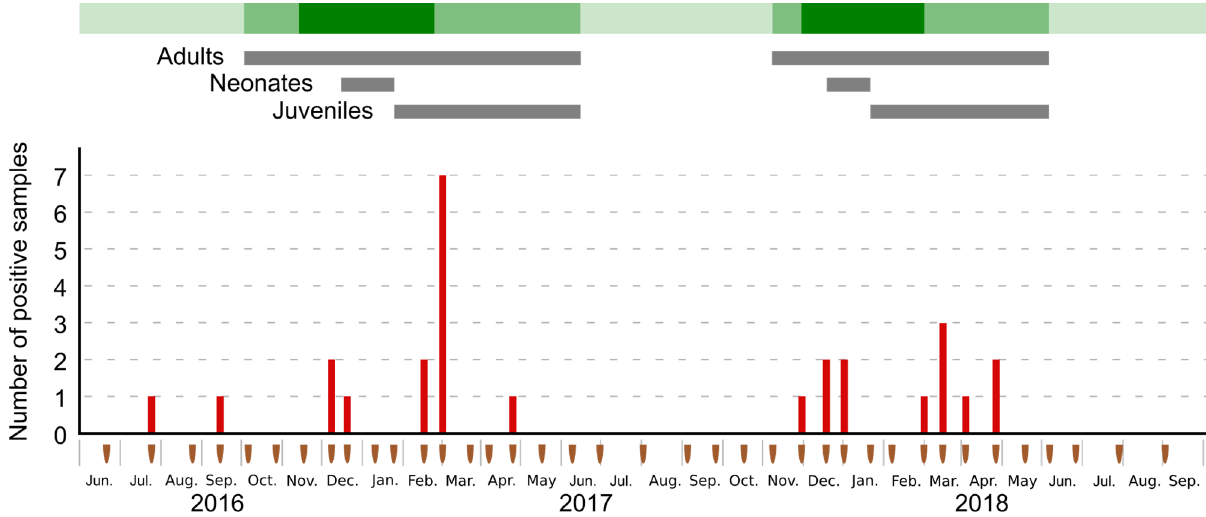
Figure 1. Number of Astrovirus positive guano samples as per sampling session (brown marks). Ten samples were collected during each sampling session. Green shading indicates the relative bat population size: light green: no bat inside the cave, mid-green: less than half of the cave occupied by bats, dark green: more than half of the cave occupied by bats. Presence of adults, neonates, and juveniles bats is represented by gray bars.